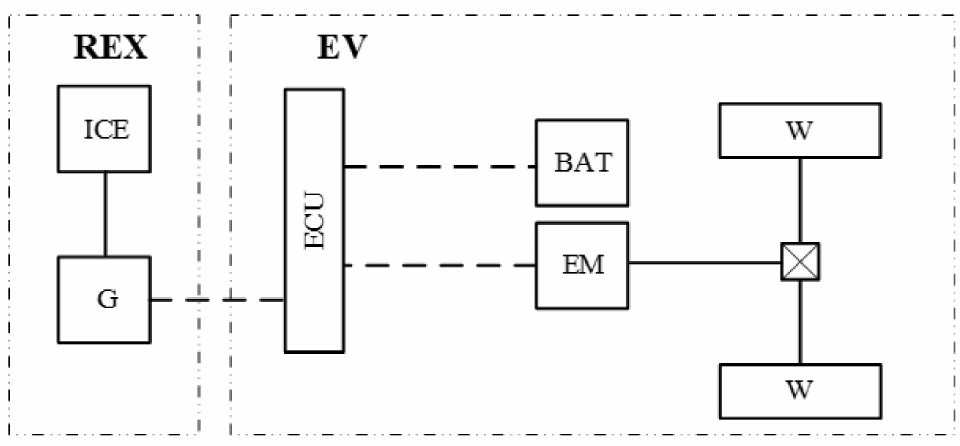
Figure 1. Vehicle powertrain diagram.